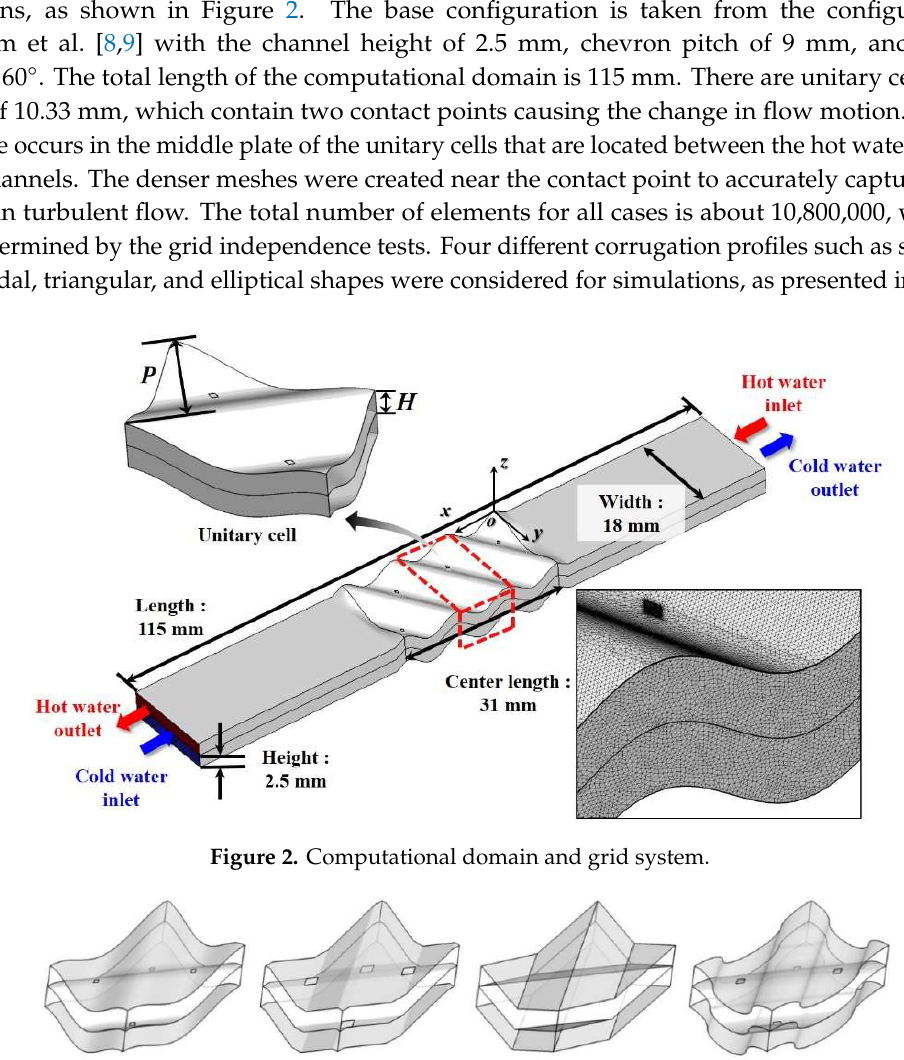
Figure 1. The configuration of the chevron shape of the plate heat exchanger: ( a ) partial plates and ( b ) a unitary cell repeated section with contact points in the flow channel.